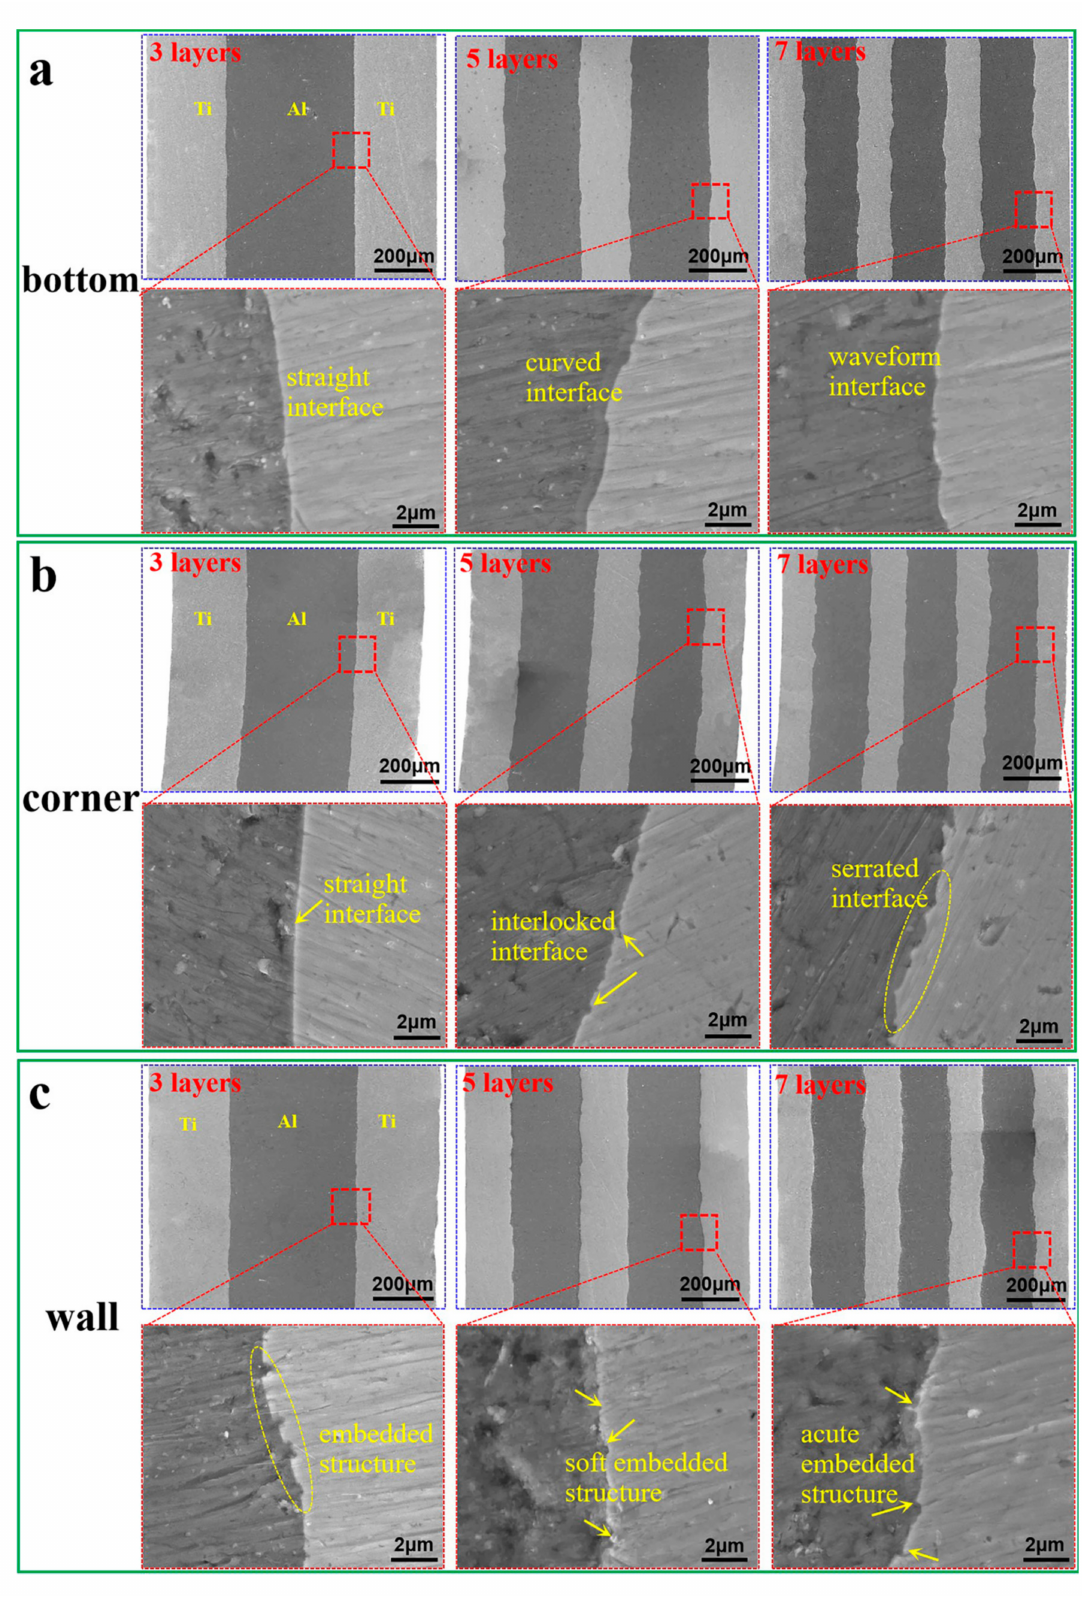
Figure 8. SEM images of the deep-drawing parts of Ti/Al multilayered composites with different layers along the RD-ND surface at the ( a ) bottom, ( b ) corner, and ( c )